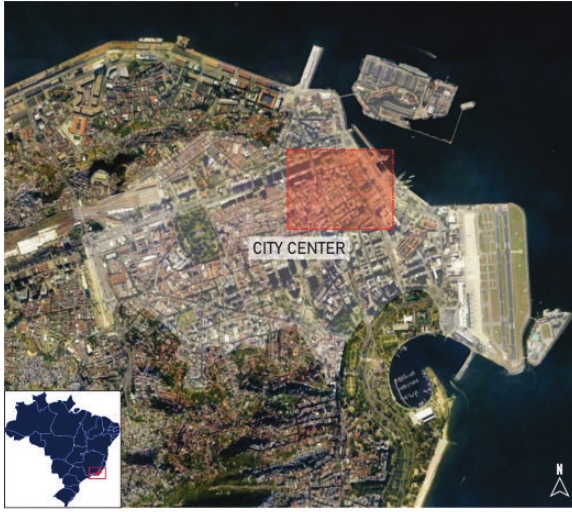
Figure 2: Study area, including traflc counting and noise measuring